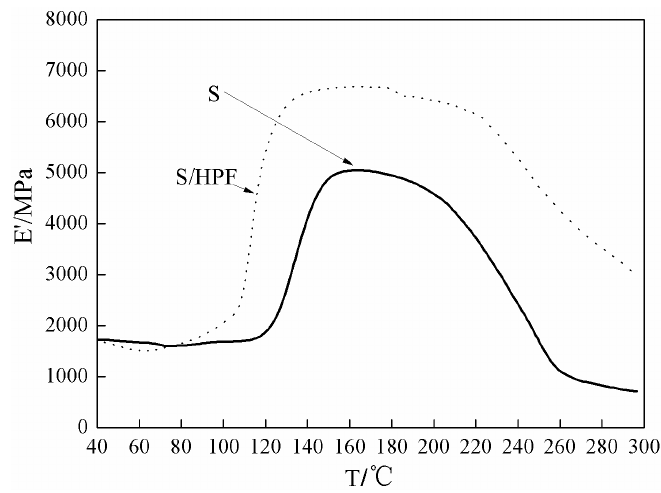
Figure 2. DMA results of soy-based adhesive and its mixture with HPF (S/HPF).